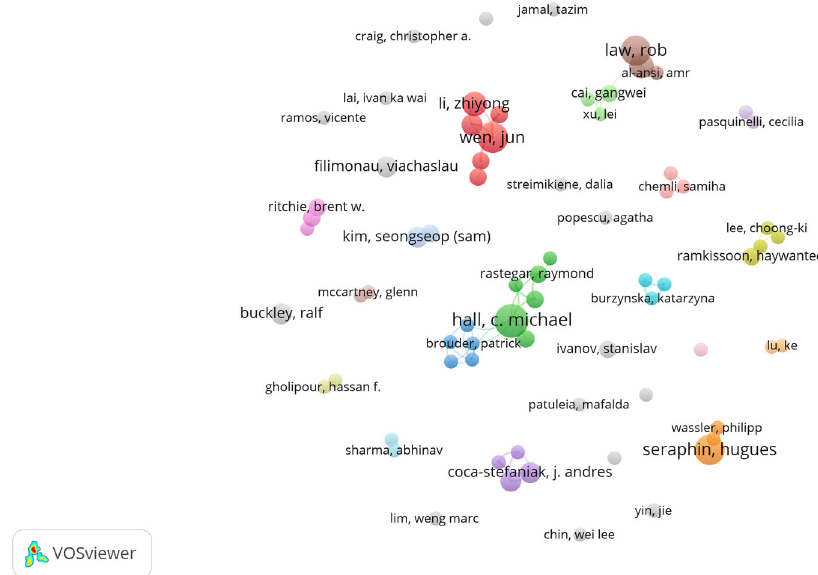
Fig. 4 Co-authorship. Map for authors with more than three publications on COVID-19 and tourism.